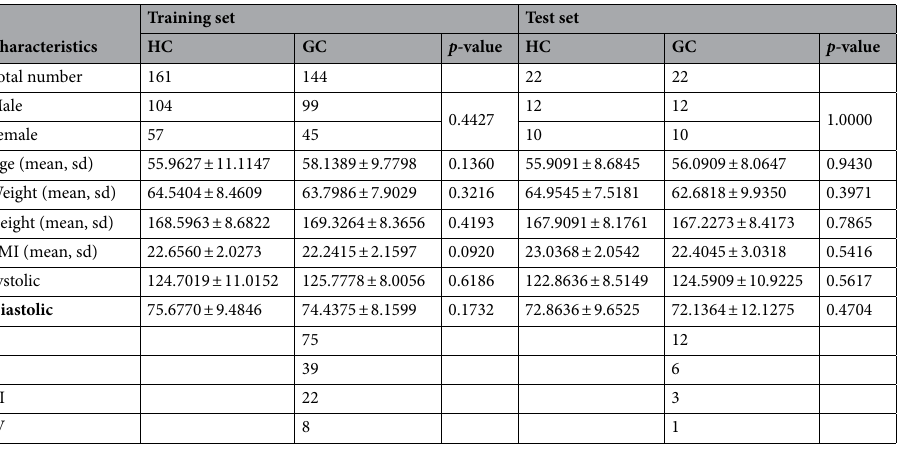
Table 1. Clinicopathologic characteristics of the whole participants. HC, healthy control; GC, gastric cancer; BMI: body-mass